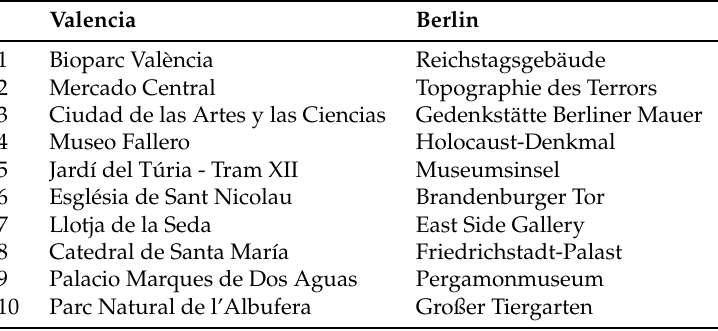
Table 3. Top ten